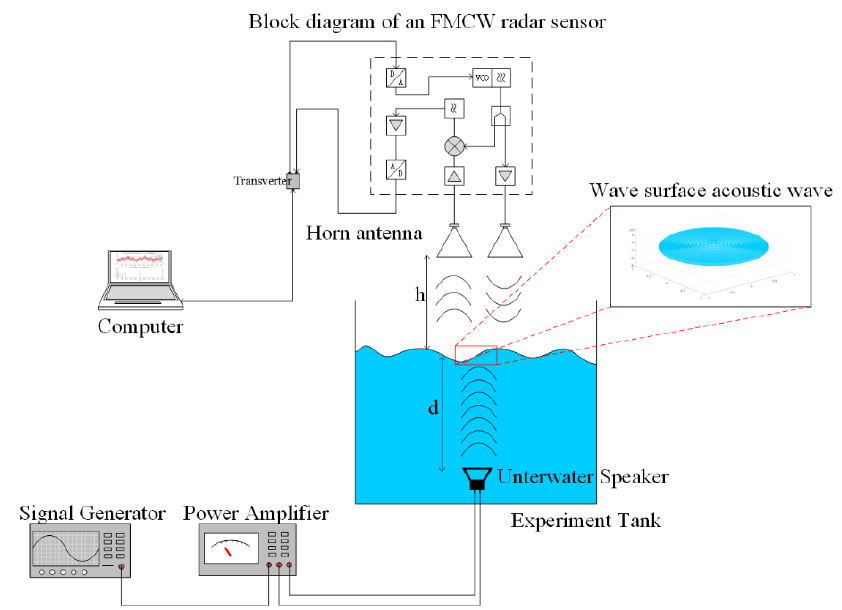
Figure 1. Schematic diagram of the experimental system.